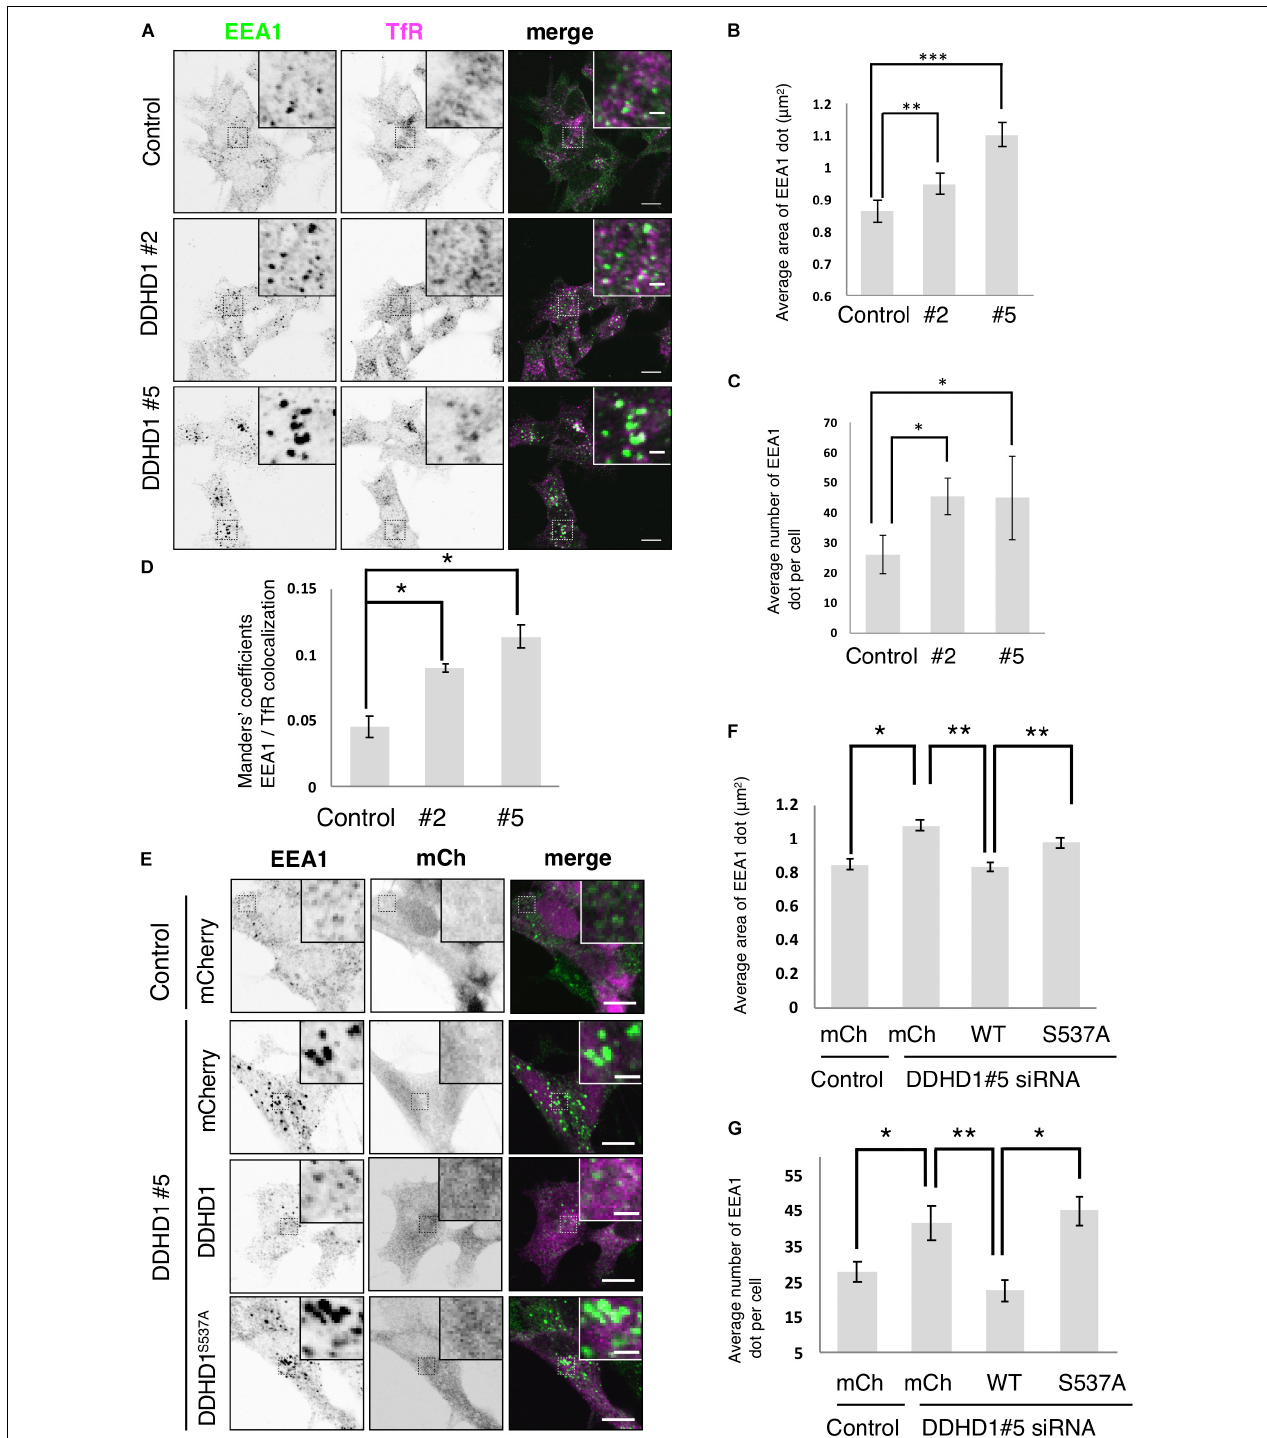
FIGURE 2 | Effects of DDHD1 knockdown on endosomal morphology in SH-SY5Y cells. (A) SH-SY5Y cells were treated with the indicated siRNAs for 72 h, and then stained with antibodies against EEA1 and TfR. Higher magnification views of the boxed areas are shown in the inset. Scale bars, 10 µ m; inset, 2 µ m. (B,C) Quantification of the data in panel (A) . The average area (B) and number (C) of early endosomes in each cell were measured under each condition. (D) Manders’ colocalization analysis of the data in panel (A) . (E) SH-SY5Y cells were treated with DDHD1 siRNA#5 or control siRNA for 48 h, and then infected with the indicated retroviruses. At 24 h after infection, the cells were fixed and stained with an antibody against EEA1. Scale bars, 10 µ m; inset, 2 µ m. (F,G) Quantification of the data in panel (E) . The average area (F) and number (G) of early endosomes in each cell were calculated. At least 30 cells were examined in each experiment. Values are expressed as means for three independent experiments ± S.D. * p < 0.05; ** p < 0.01; *** p < 0.001 (Tukey test).